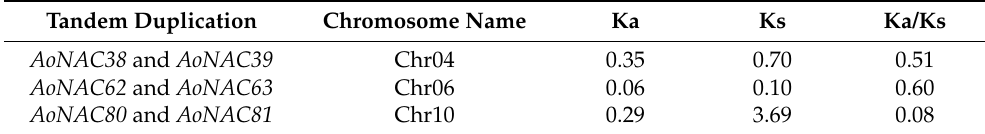
Figure 5. Schematic diagram of the duplication patterns of the AoNAC genes. The blue lines indicate segmental duplications of AoNAC gene pairs, and the red lines indicate tandem duplications of AoNAC gene pairs. Table 2. Tandem duplication in AoNAC genes and corresponding Ka, Ks, and Ka/Ks